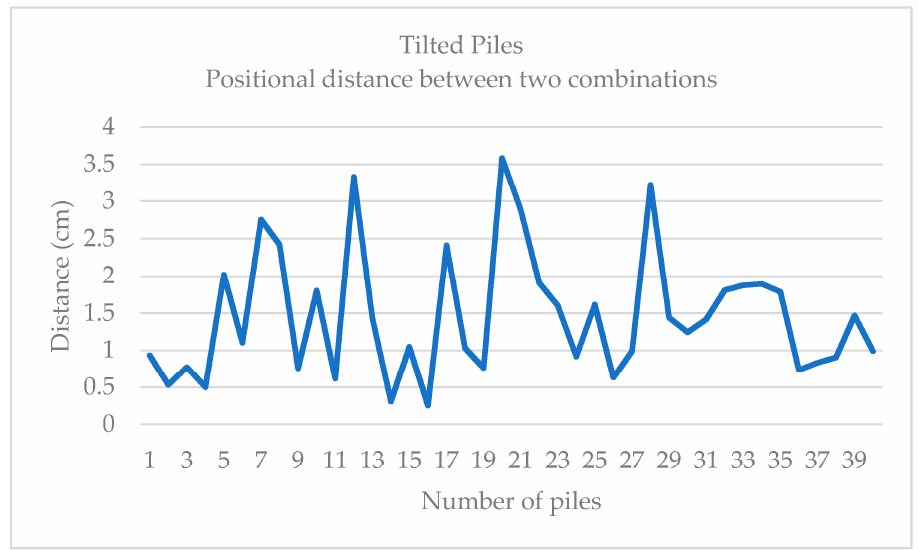
Figure 18. Positional difference between two combinations for tilted piles.